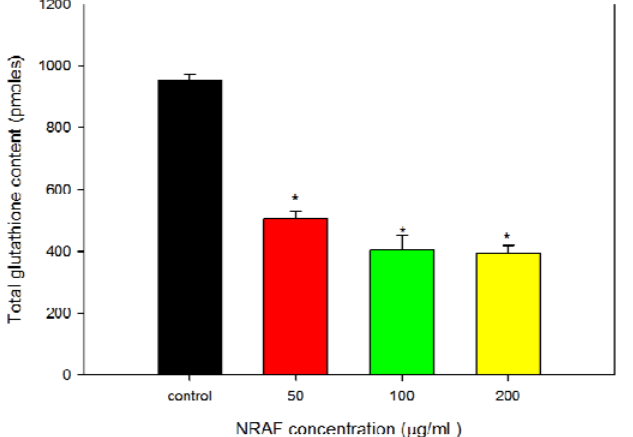
Figure 7. Effect of NRAF on intracellular total glutathione content of HT-29 cells at 24 h. There was a significant reduction in intracellular GSH content (>50%) after treatment with varying concentrations of NRAF (50–200 µg/mL). The data expressed as mean ± SE of three independent experiments (n = 9). Asterisks indicate significantly different value from control ( * p <